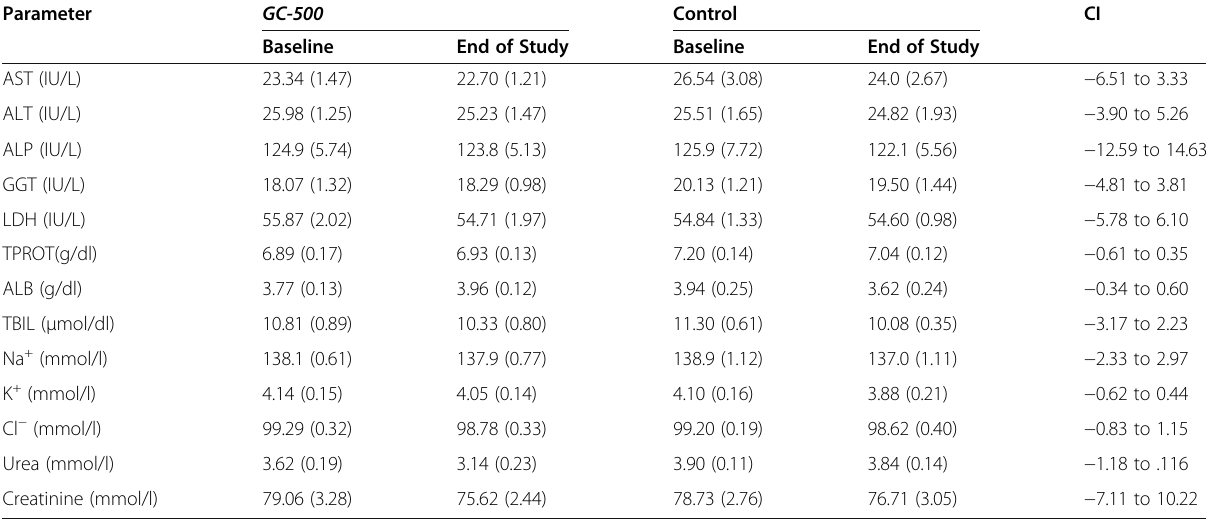
Table 3 Biochemical Profile for GC-500 compared to the control treatment Parameter GC-500